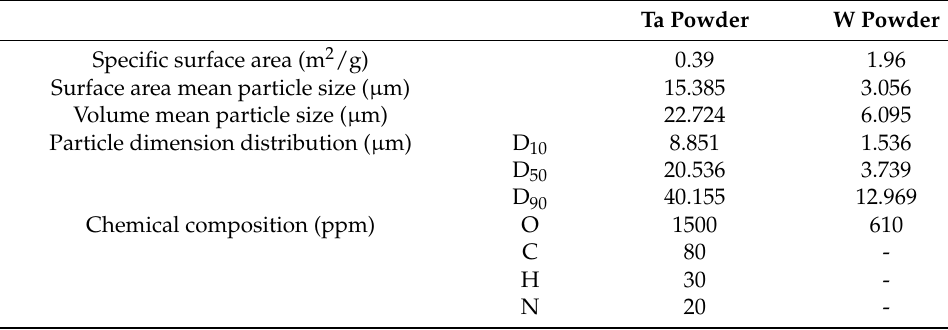
Table 1. Characterization and chemical composition of raw materials. Ta Powder W Powder Specific surface area (m 2 /g) 0.39